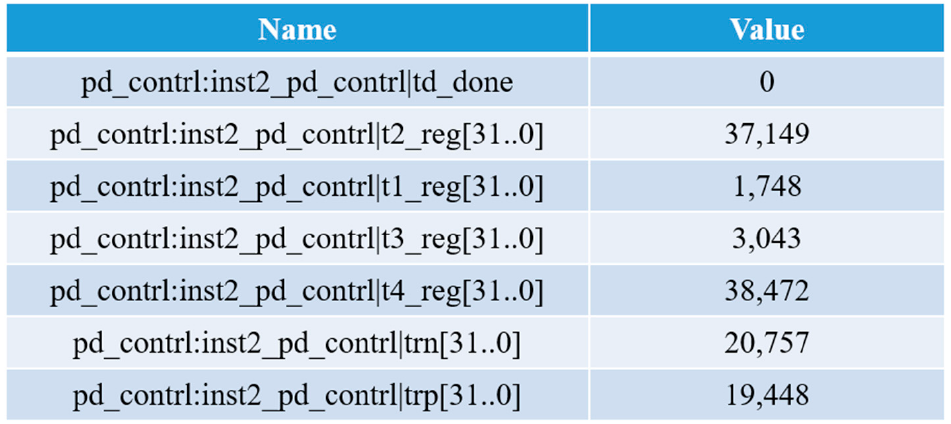
Figure 19. The signal captured by an FPGA logic analyzer.